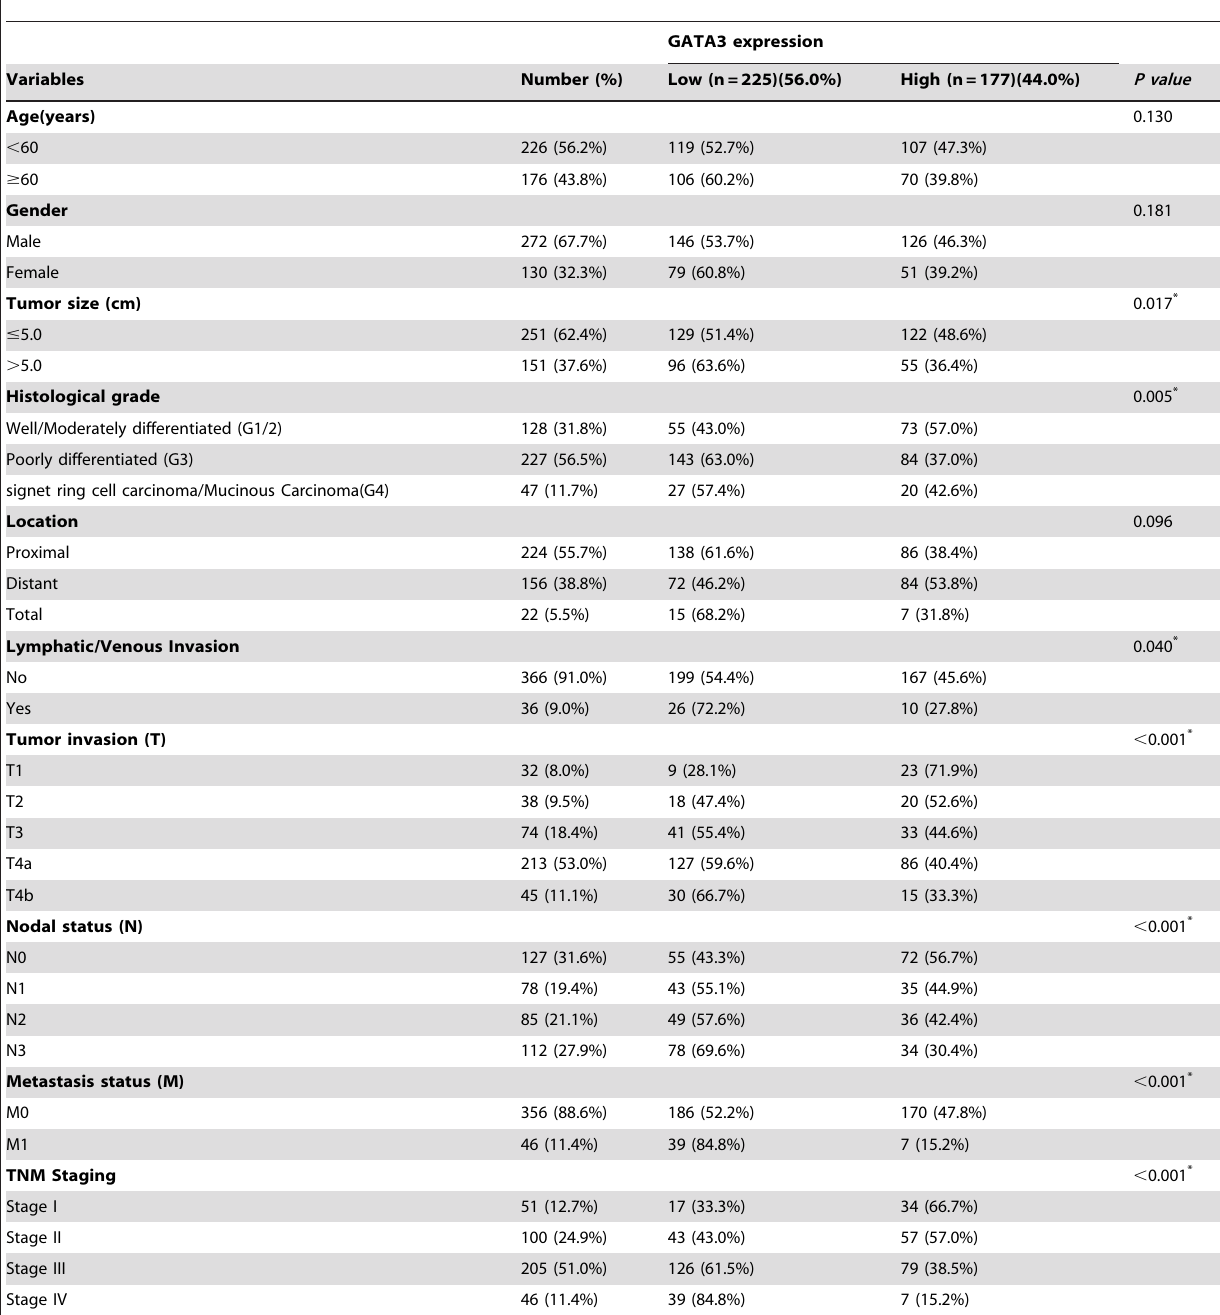
Table 1. Relationship between the GATA3 expression and clinicopathologic features of patients with gastric cancer (n=402).